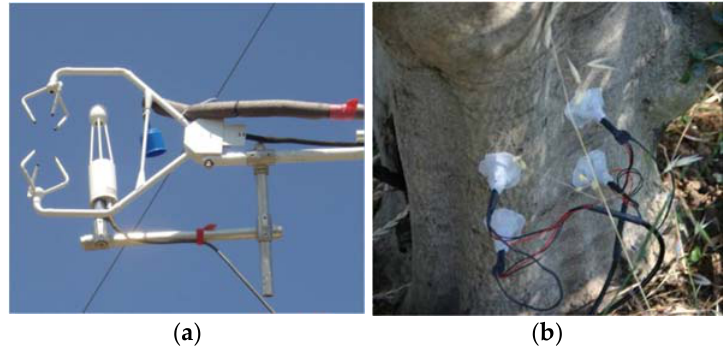
Figure 3. 3D Sonic anemometer and an infrared gas analyzer (IRGA) ( a ) and SF probes ( b ).